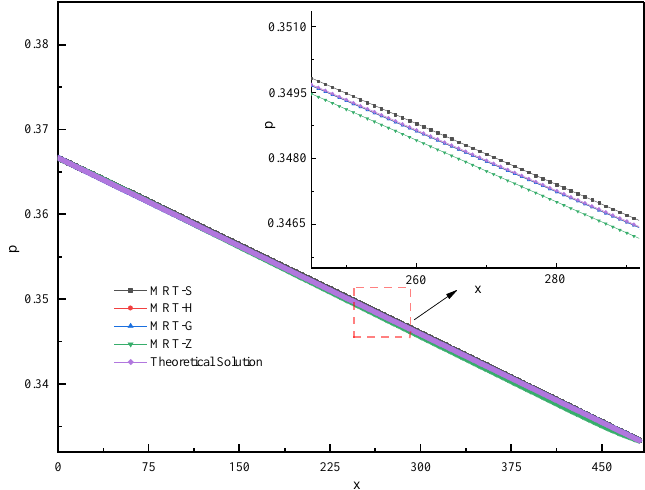
Figure 3. The profiles of pressure along channel centerline (y = 40.5).